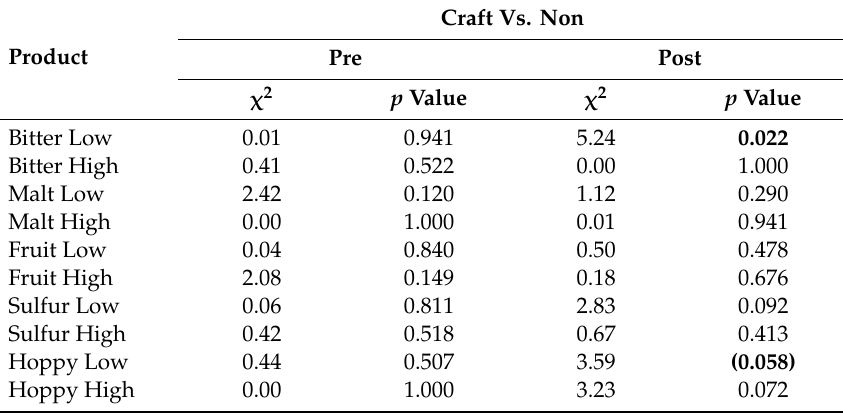
Table 2. Chi-squared tests based on number of correct versus incorrect attribute identifications, with Yates correction. Significant di ff erences are marked in